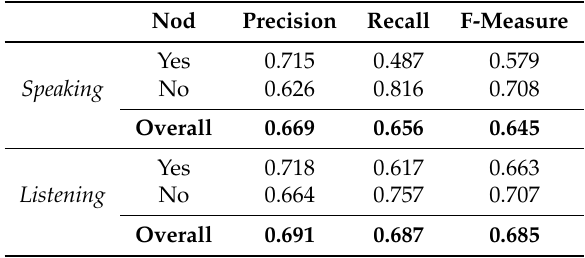
Table 7. Yes/No classification results of the proposed nodding prediction models with all available feature sets.